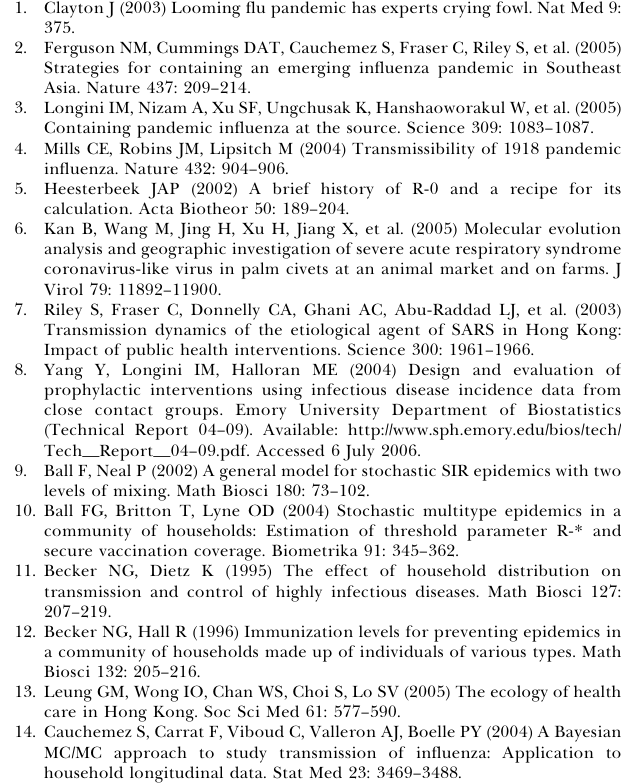
Figure S1. Time-Dependent Infection Import Rate Found at DOI: 10.1371/journal.pmed.0030361.sg001 (26 KB PDF).